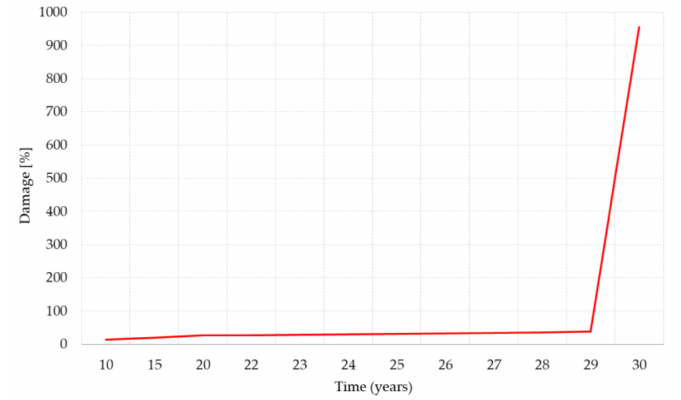
Figure 26. Actual variation of damage (%)